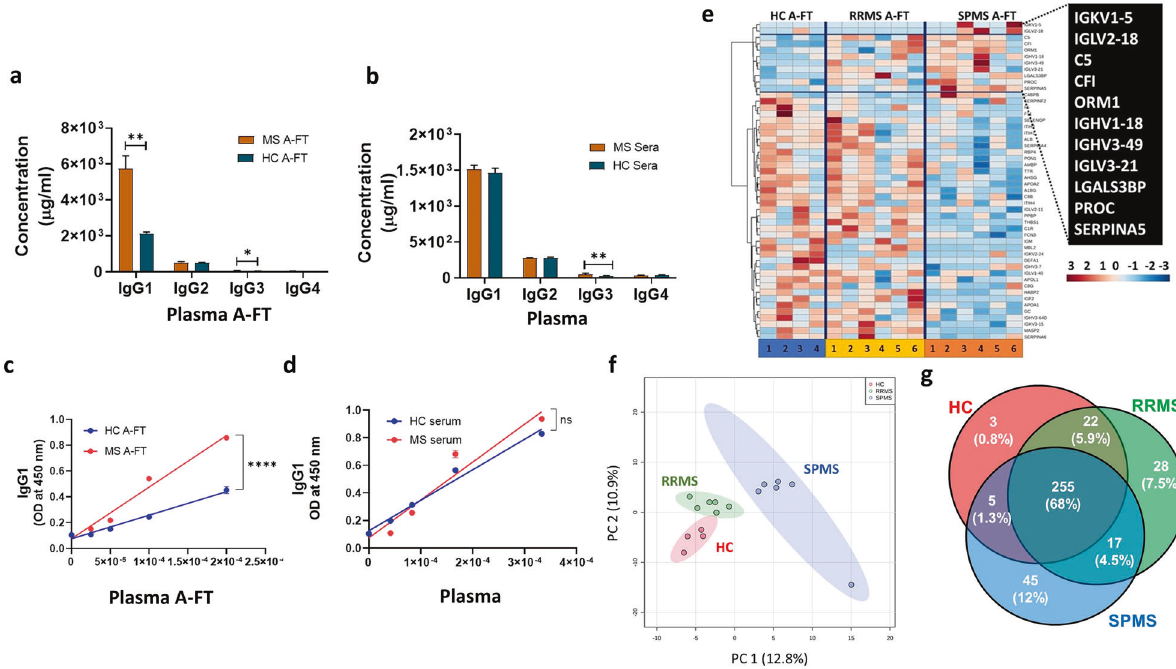
Fig. 1 Signi fi cantly higher levels of IgG1 and IgG3 antibodies are detected in the fl ow-through after Protein A incubation with MS plasma. a Signi fi cantly higher levels of IgG1 and IgG3 were detected in MS A-FT ( n = 7) compared to HC A-FT ( n = 4) ( p = 0.0061 for IgG1, p = 0.04 for IgG3, Mann Whitney test). b No differences in IgG1 but higher levels of IgG3 were found in MS plasma compared to HC ( p = 0.0061). c IgG1 dose-response ELISA con fi rmed the presence of higher levels of IgG1 in MS A-FT compared to HC A-FT. d No difference in IgG1 was detected in the original MS plasma compared to HC plasma. e Heatmap of Mass Spec proteomic analyses revealed that MS A-FT has higher levels of unique protein sets consisting of IgG heavy and light chains and complement components (highlighted in the black box). SPMS = 6, RRMS = 6, HC = 4. f Principal component analysis shows that clear distinctions between SPMS, RRMS, and HC are observed based on proteomics of plasma A-FT. g Venn diagram showing the number of proteins identi fi ed in each